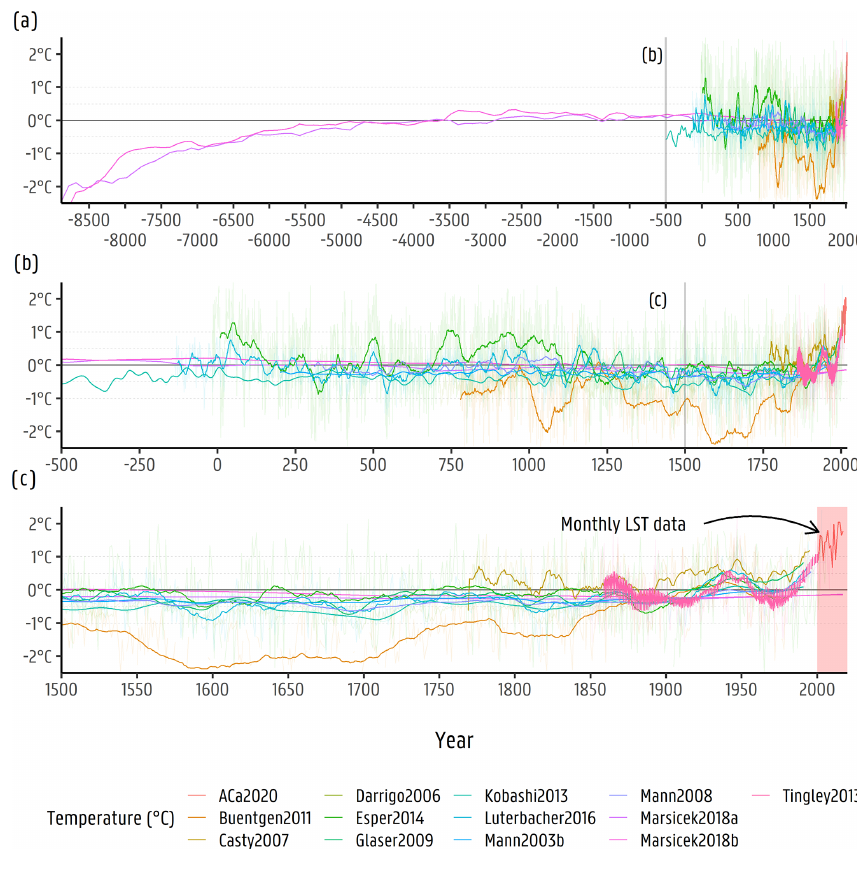
Figure A5. Temperature–time curve for each author in the legend scaled to the 1961–1990 Belgian average for the past 10519 years.